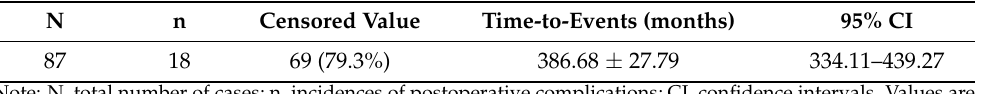
Table 5. Overall complication-free survival.